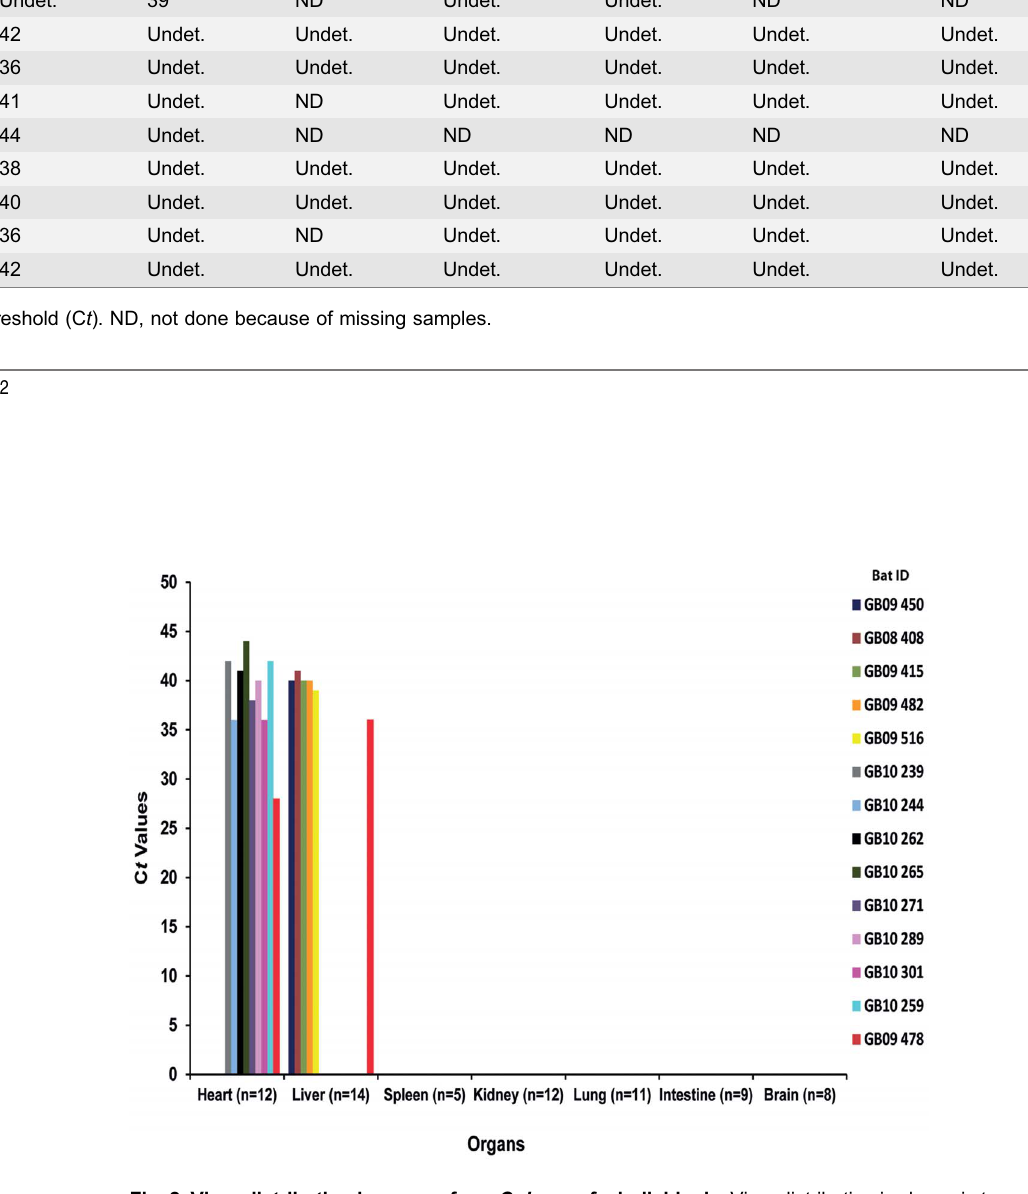
Undet. Undet. Undet.